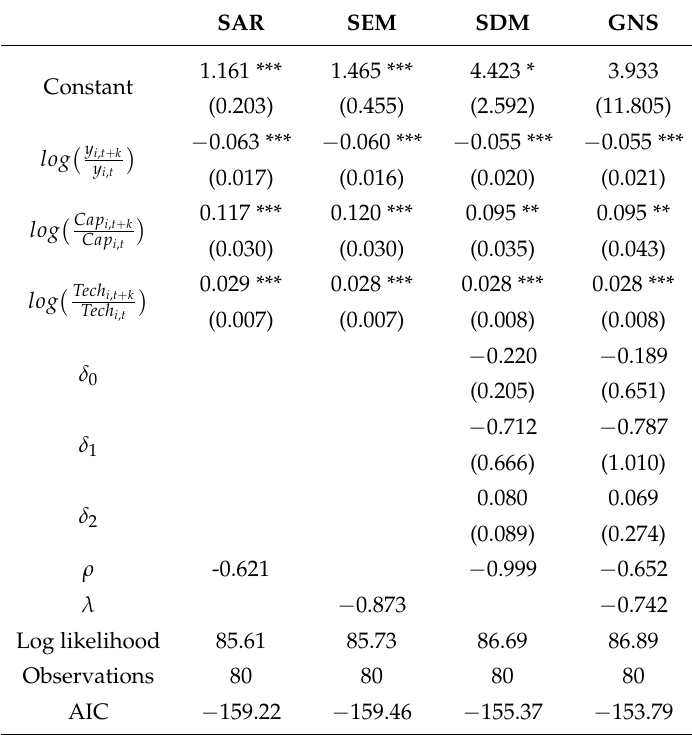
Table 4. Conditional β -convergence models for 2010–2014. The weight matrix is specialization